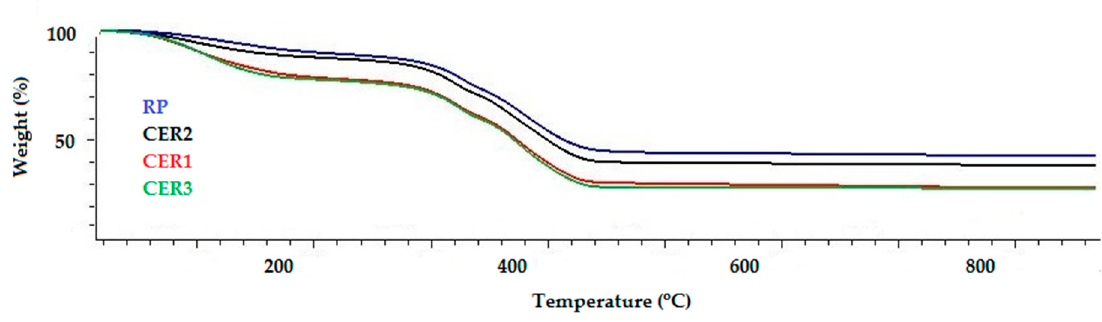
Figure 2. Thermogravimetric curve of the coatings with scan rate of 10 °C/min, from 25 to 800 °C.